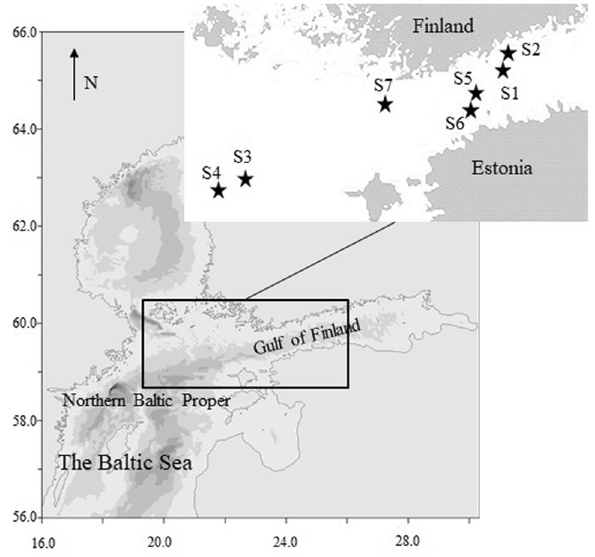
Fig. 1 Sampling sites of the studied sediments S1 − S7 in the north- ern Baltic Proper and in the Gulf of Finland, Baltic